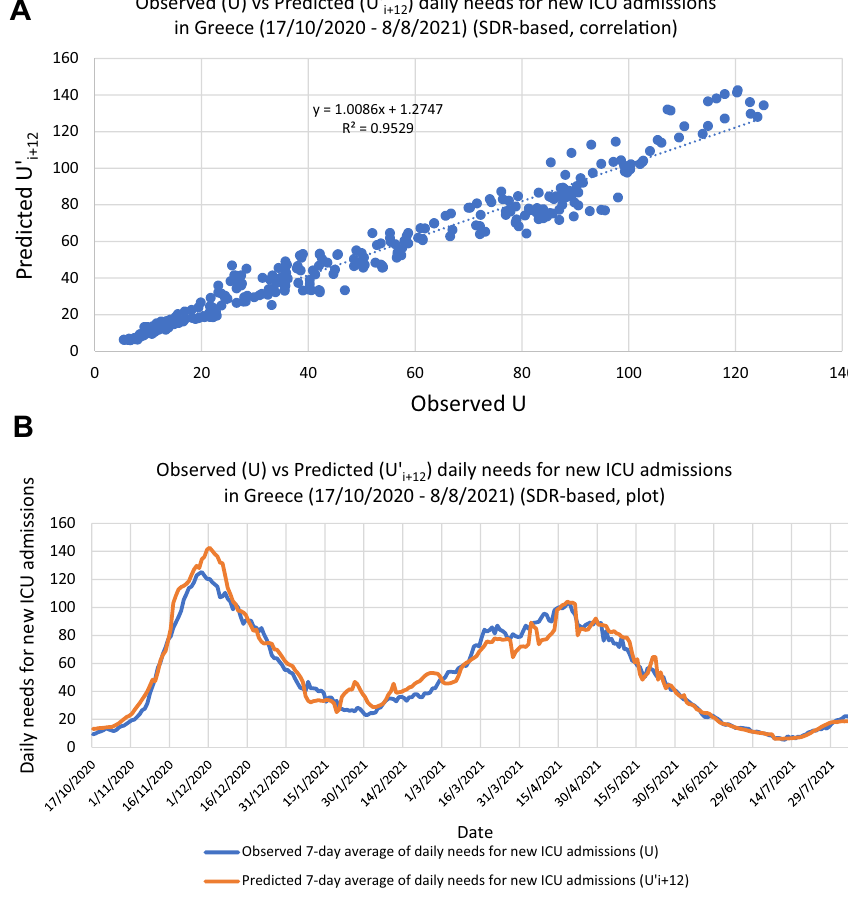
Figure 4. ( A ) Correlation between observed and predicted daily needs for new ICU admissions for the period between 17/10/2020 and 8/8/2021 employing Severity Detection Rate regression equations, with Pearson r = 0.98, p = 10 –197 , RMSE = 7.16; with n = 296, observed U[max] = 125, U[average] = 51. ( B ) The respective time- series plots for visual inspection of the